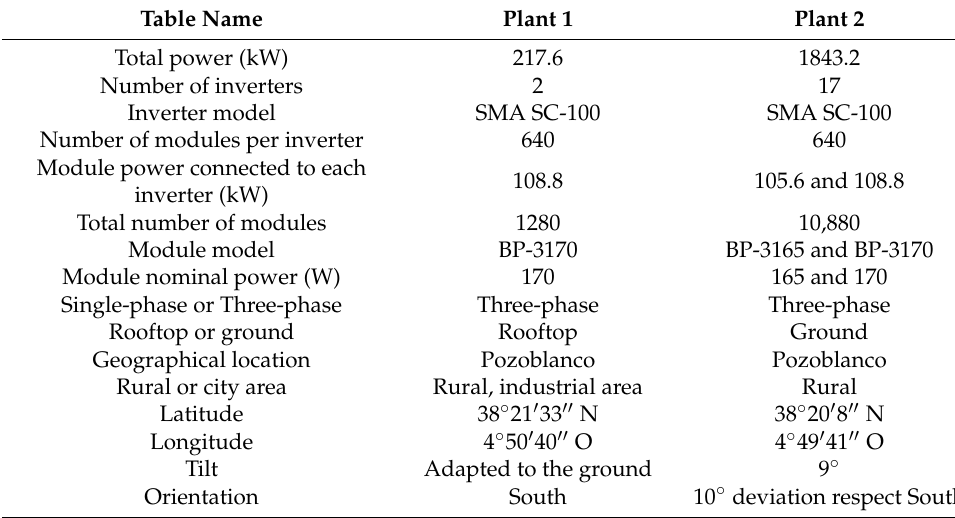
Table 8. Main technical characteristics of PV plants